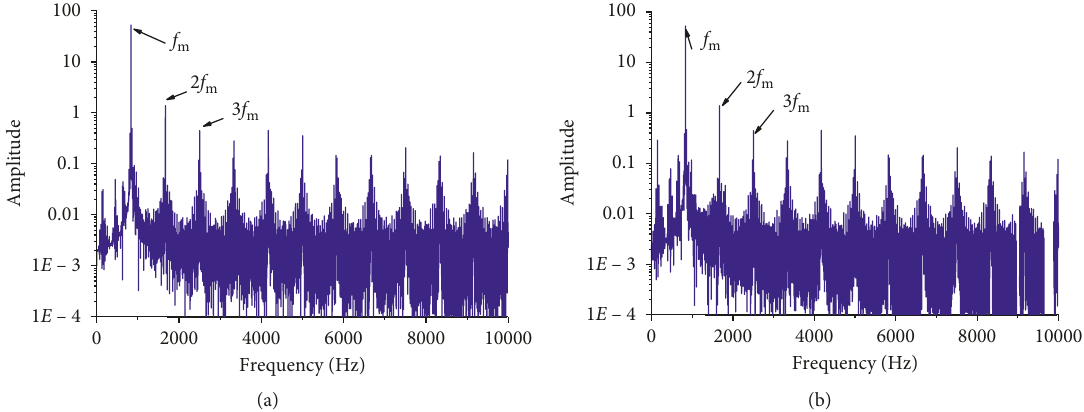
Figure 13: Frequency spectrum diagram of vertical vibration acceleration of bogie (frequency range: 0–10000): (a) health gear (b) the crack length of the pinion is